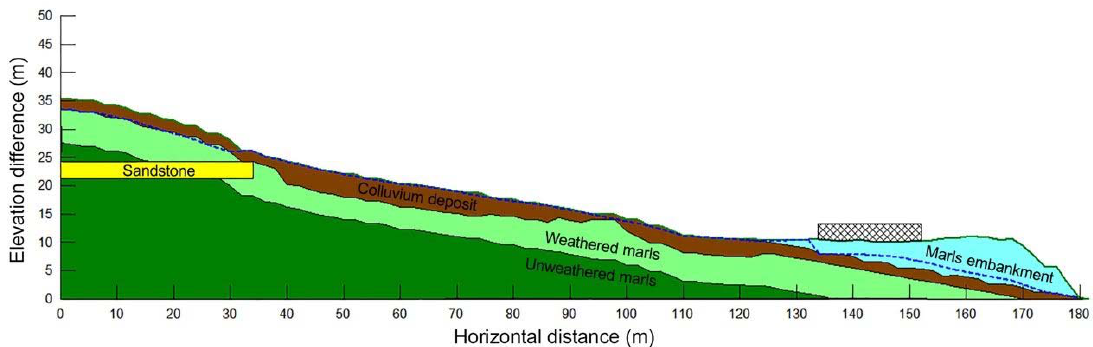
Figure 12. Geological model of the Espogueiro profile.